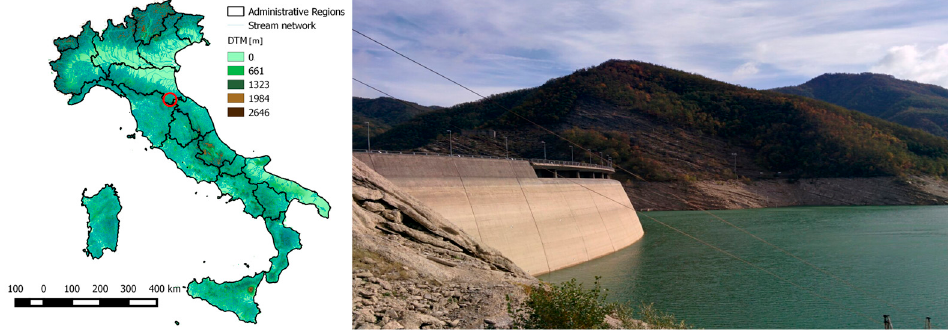
Figure 1. The test case study area is located in the Emilia Romagna Region, Central Italy. The red circle identifies the location of the area, left panel. The experiment is performed at the Ridracoli lake, artificially created by the construction of the homonymous dam, right panel.